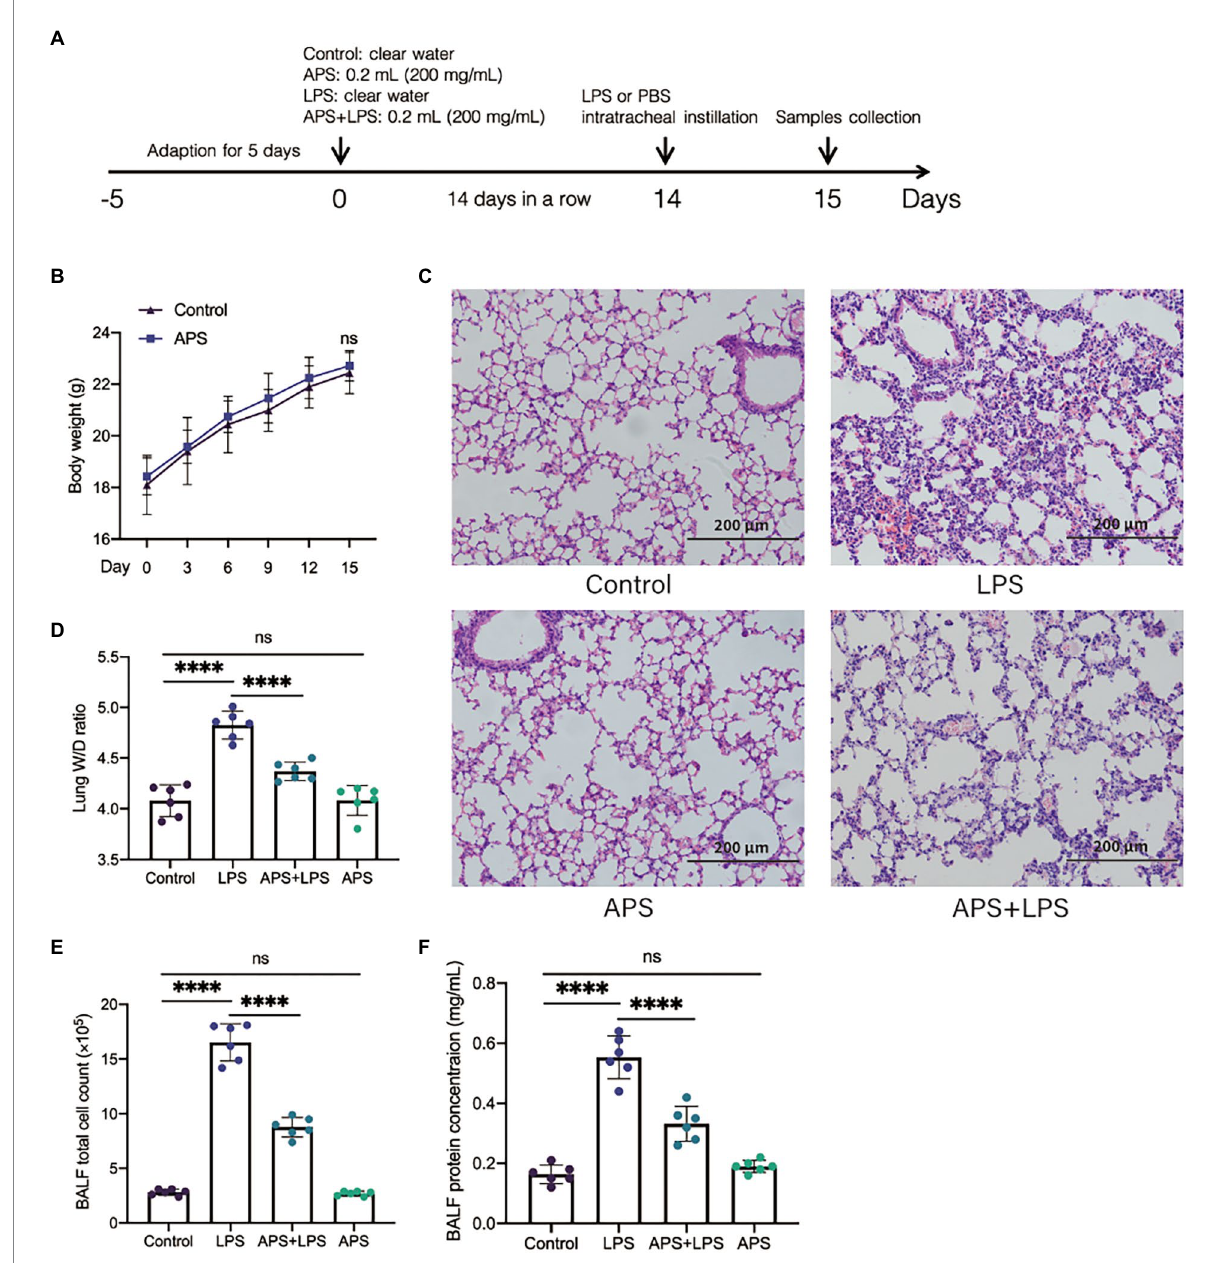
FIGURE 2 APS pre-treatment alleviated the inflammatory lung injury following lipopolysaccharides (LPS) exposure. (A) The schematic of the experimental design. Twenty-four hours post LPS instillation, samples were collected. (B) The body weight of mice with or without APS treatment before LPS exposure. (C) Representative pictures of lung tissues with hematoxylin and eosin (H&E) staining. (D) The ratio of lung wet weight and dry weight with n = 6 sample per group. (E) The number of total cells in bronchoalveolar lavage fluid (BALF) with n = 6 sample per group. (F) The total protein concentration in BALF was measured by BCA analysis with n = 6 sample per group. Statistical significance was determined by one-way ANOVA using GraphPad Prism 8 software. **** p <